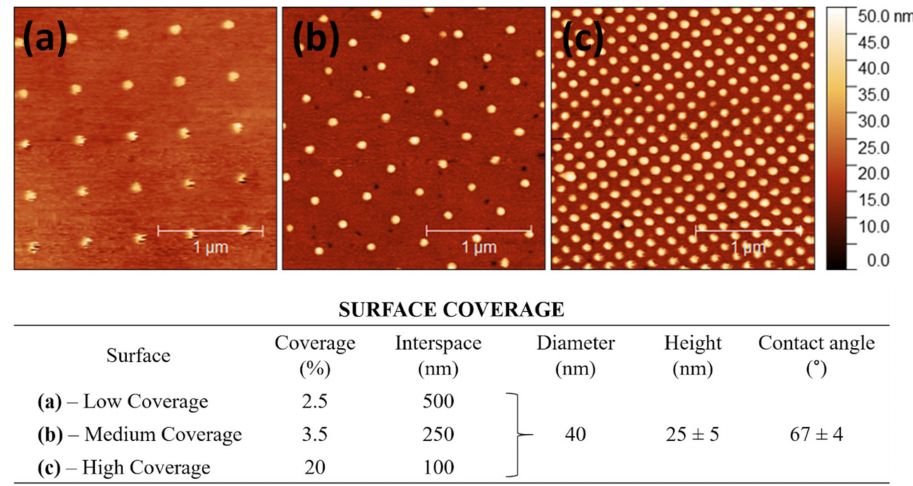
Figure 2. AFM images of surfaces with scale presented height (nm): ( a ) low coverage (LC), ( b ) medium coverage (MC), ( c ) high coverage (HC), and table below showing the characterization of the nanopillars with interspace, diameter, and height ( n =